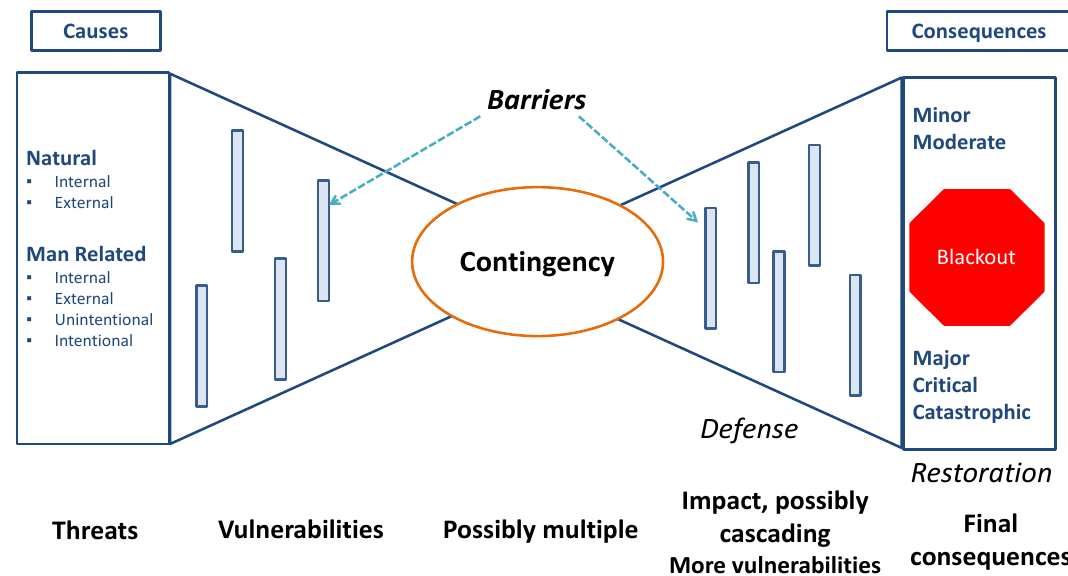
Figure 1. The bow-tie conceptual scheme [10].